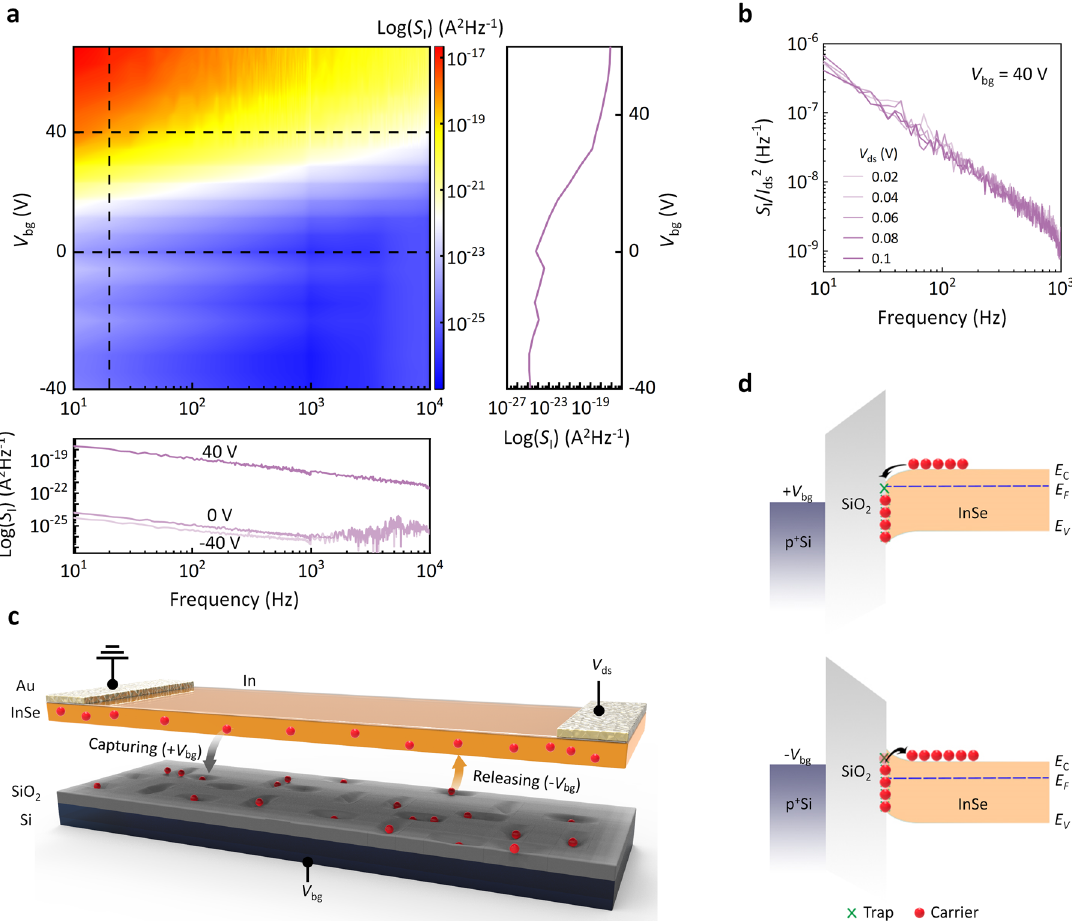
Fig. 5 Mechanism of carrier fl uctuations and energy-band diagrams. a Power spectral map of the current fl uctuations ( S I ) at different V bg as a function of frequency, the curves of S I versus frequency at V bg = − 40, 0, and 40 V are listed at the bottom and the S I – V bg curve at 20 Hz is plotted on the right. b Normalized S I as a function of frequency at diverse V ds and V bg = 40 V. c Schematic of the trapping/detrapping events at the interface between the InSe semiconductor and the SiO 2 layer. d Energy-band diagrams of the carrier capture and release process. Note the corresponding band diagrams of the InSe-based synaptic device under light illumination are shown in the Supplementary